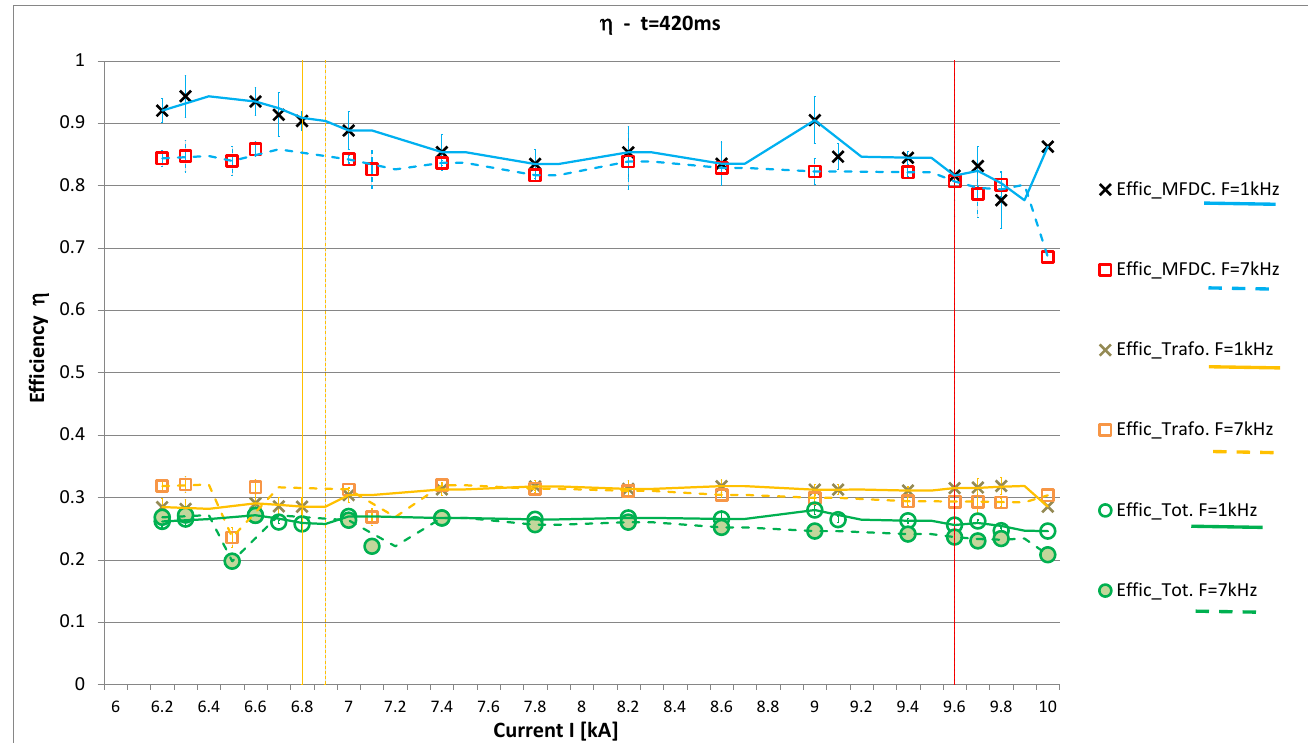
Figure 14. Converter efficiency for 1 kHz and 7 kHz in blue; efficiency of the transformer + rectifier + interconnection block for both frequencies in yellow; efficiency of the complete process for the two study frequencies in green.